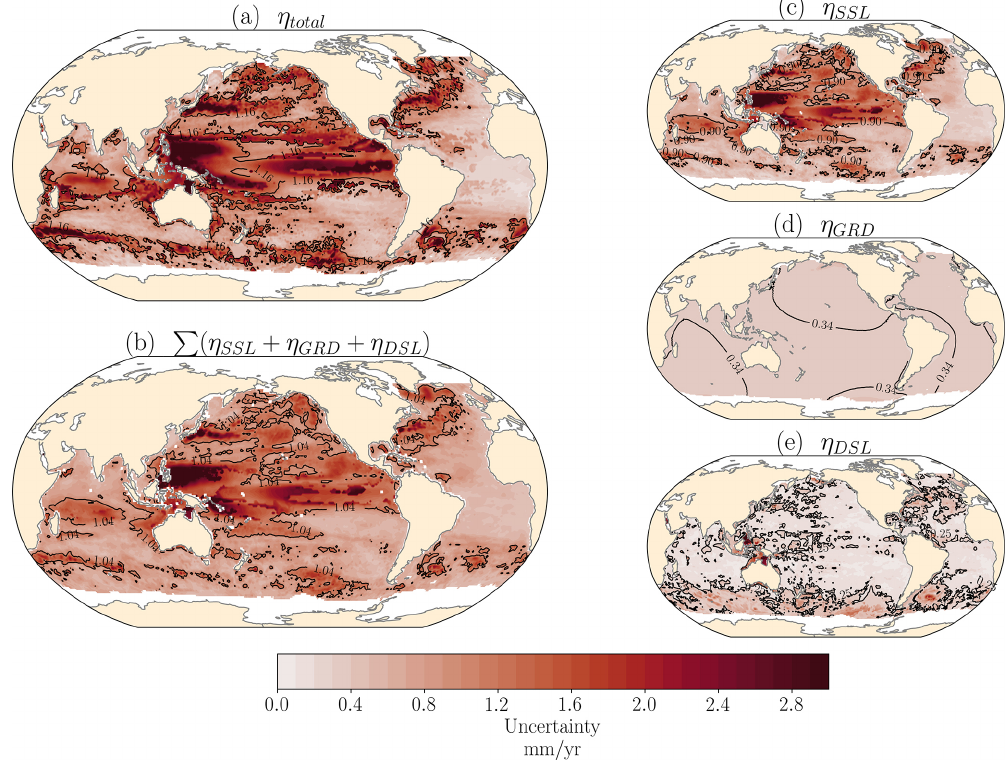
Figure A2. Uncertainties of the regional sea-level trends (Fig. 1) for 1993–2016 (mmyr − 1 ) for (a) altimetry, (b) sum of sea-level components, (c) full-depth steric, (d) GRD effect, and (f) dynamic sea-level change. The black contour line indicates global mean sea-level change.